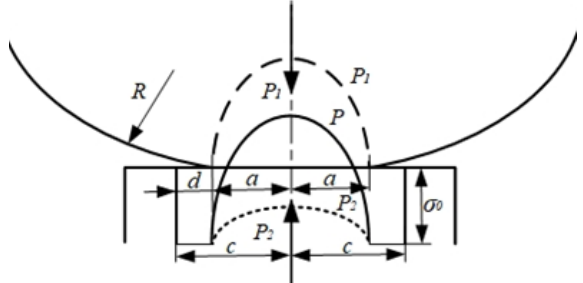
Figure 1. Schematic diagram of the M–D